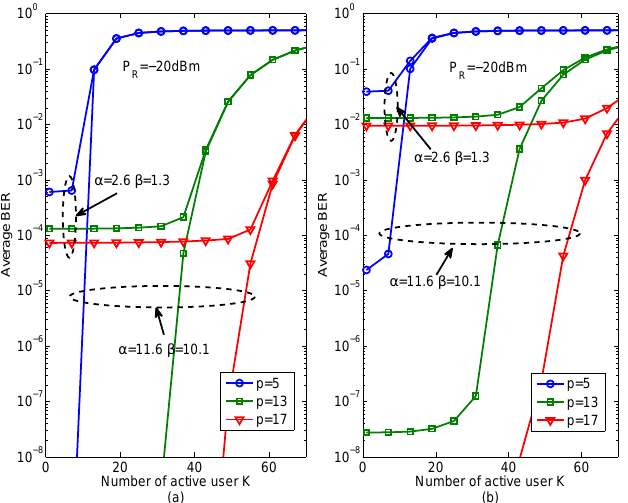
Figure 3. Average BER versus the number of active users with different prime code = − 20 dBm under the turbulence effect. ( a ) Heterodyne detection; parameters when P R ( b ) direct detection.